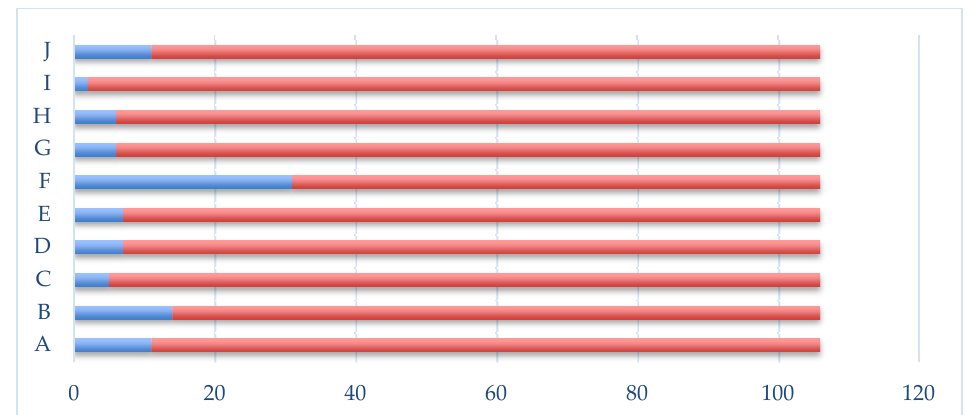
Figure 1. Distribution of complex aero-digestive cervical trauma cases and associated injuries.